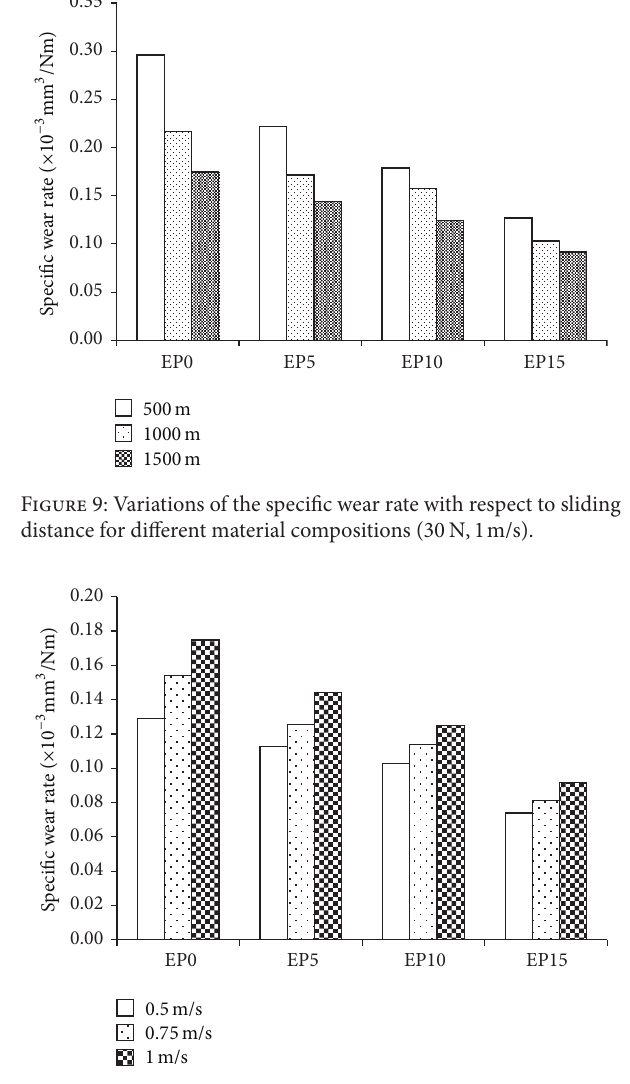
Figure 10: Variations of the specific wear rate with respect to sliding velocity for different material compositions (30 N, 1500